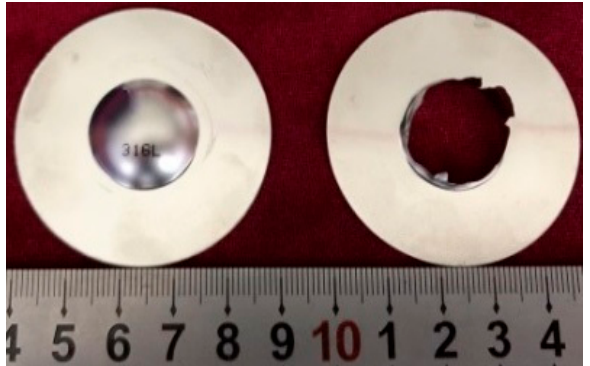
Figure 3. The domed disc before (left) and after (right) bursting.